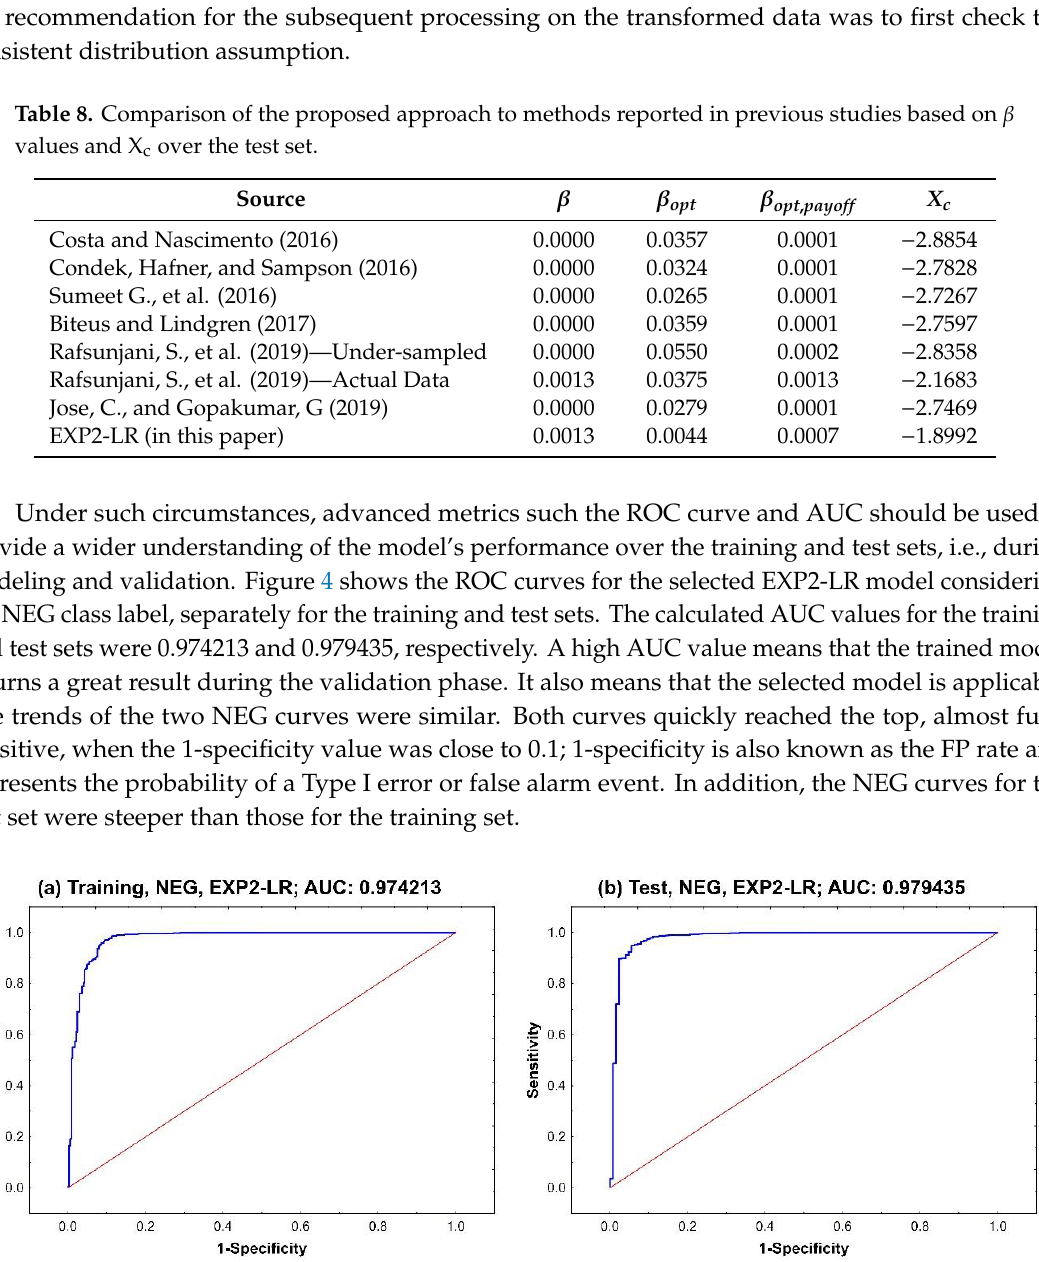
Figure 4. Receiver operating characteristic (ROC) curves and area under the curve (AUC) values of EXP2-LR for the NEG class label: ( a ) training set and ( b ) test set.